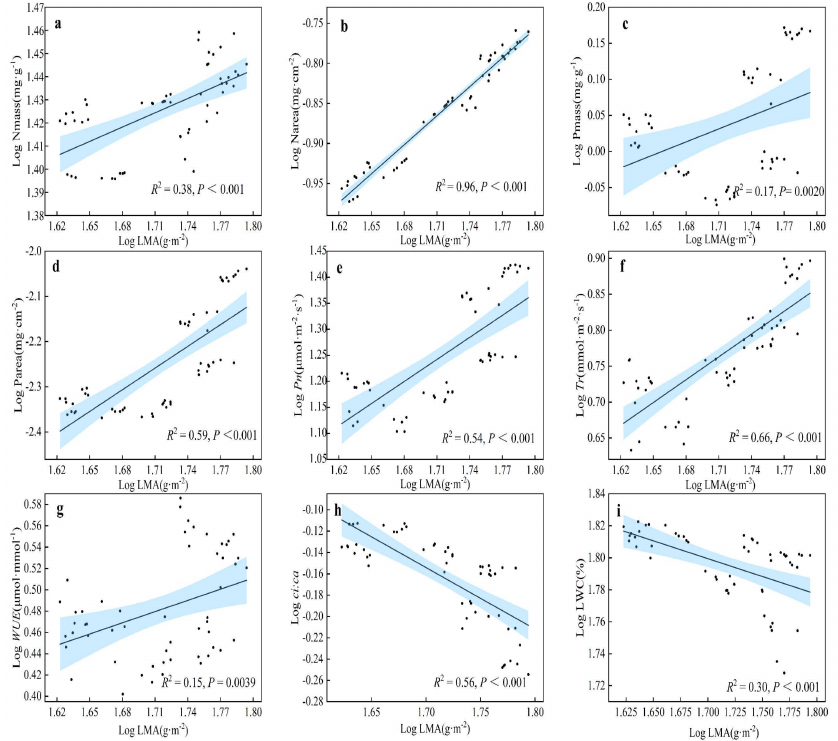
Figure 7. Linear regression relationship of LMA with other leaf functional traits. ( a ) Linear regression relationship between LMA and Nmass. ( b ) Linear regression relationship between LMA and Narea. ( c ) Linear regression relationship between LMA and Pmass. ( d ) Linear regression relationship between LMA and Parea. ( e ) Linear regression relationship between LMA and Pn. ( f ) Linear regression relationship between LMA and Tr. ( g ) Linear regression relationship between LMA and WUE. ( h ) Linear regression relationship between LMA and ci:ca. ( i ) Linear regression relationship between LMA and